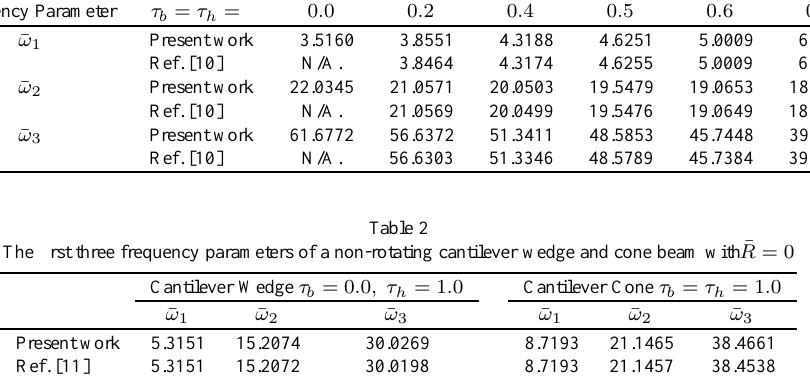
Effect of equal tapering on the frequency parameters of a non-rotating truncated cone cantilever beam with ¯ R = 0 Frequency Parameter